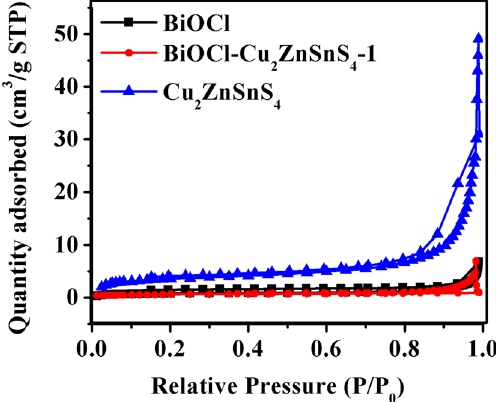
Fig. 6 Photoluminescence spectra of BiOCl, BiOCl–Cu and BiOCl–Cu 2 ZnSnS 4 -2